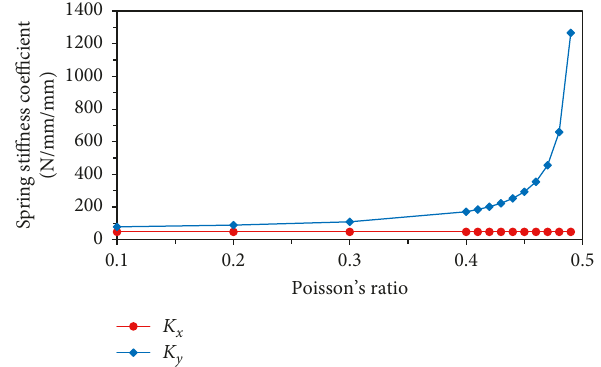
Figure 18: Effect of Poisson’s ratio of the isolation material on the isolation layer spring stiffness.